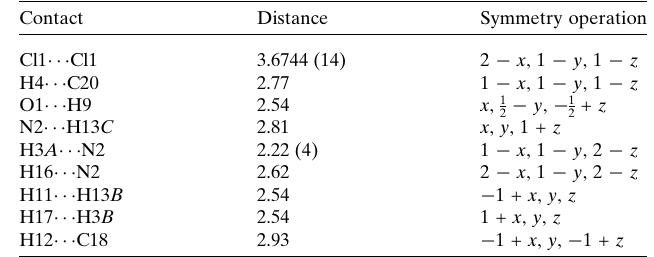
Table 2 Interatomic contacts of the title compound (A˚ ).